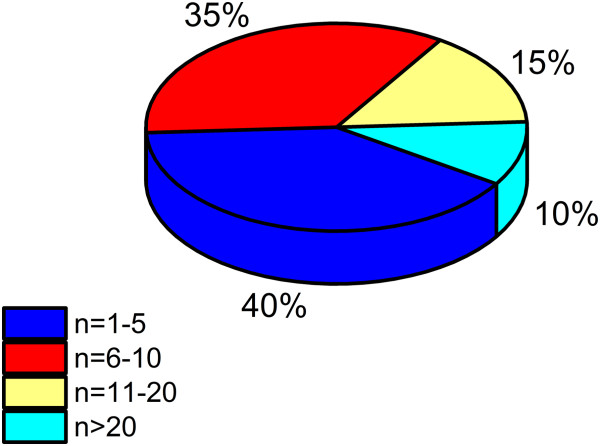
Group sizes for Wii Fit Interventions. A majority of Wii Fit intervention studies have utilized group sizes of 10 participants or less.
[1,2,4,7,10,14,15,17-19,21,22,27-31,34,36].